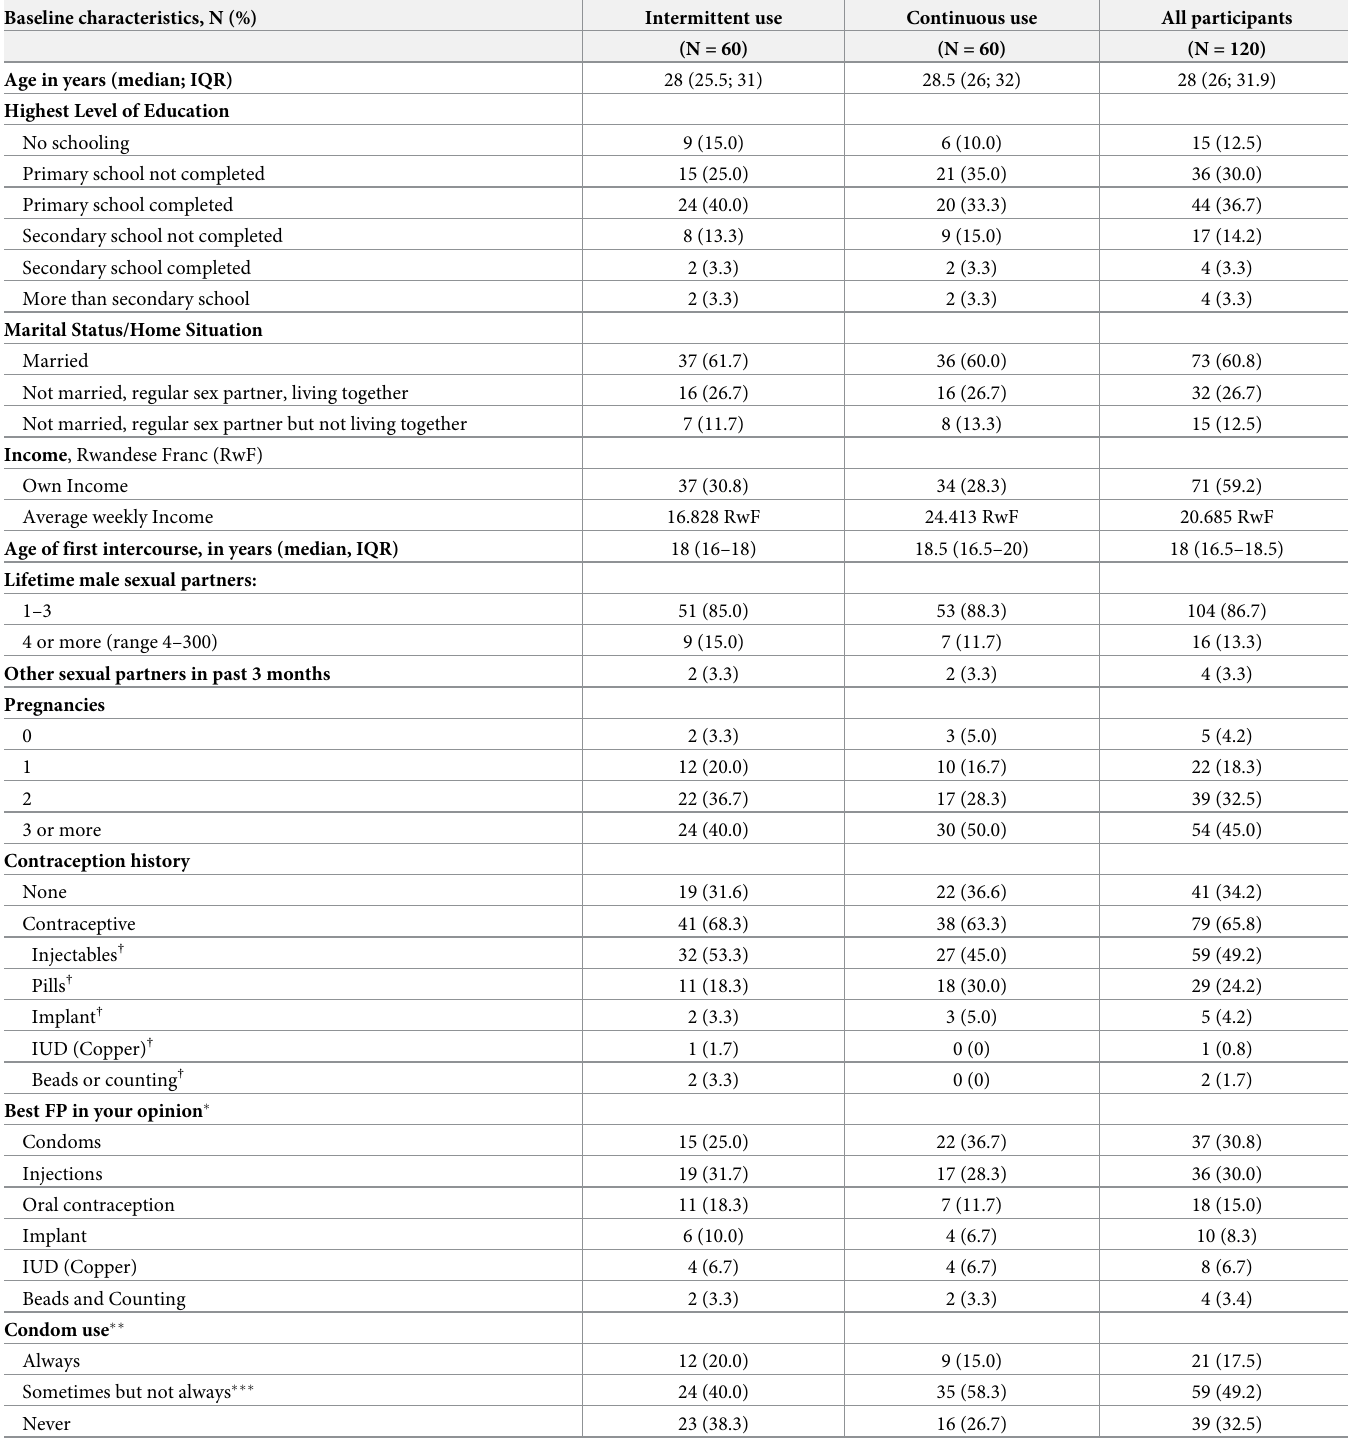
Table 1. Socio-demographic characteristics of enrolled